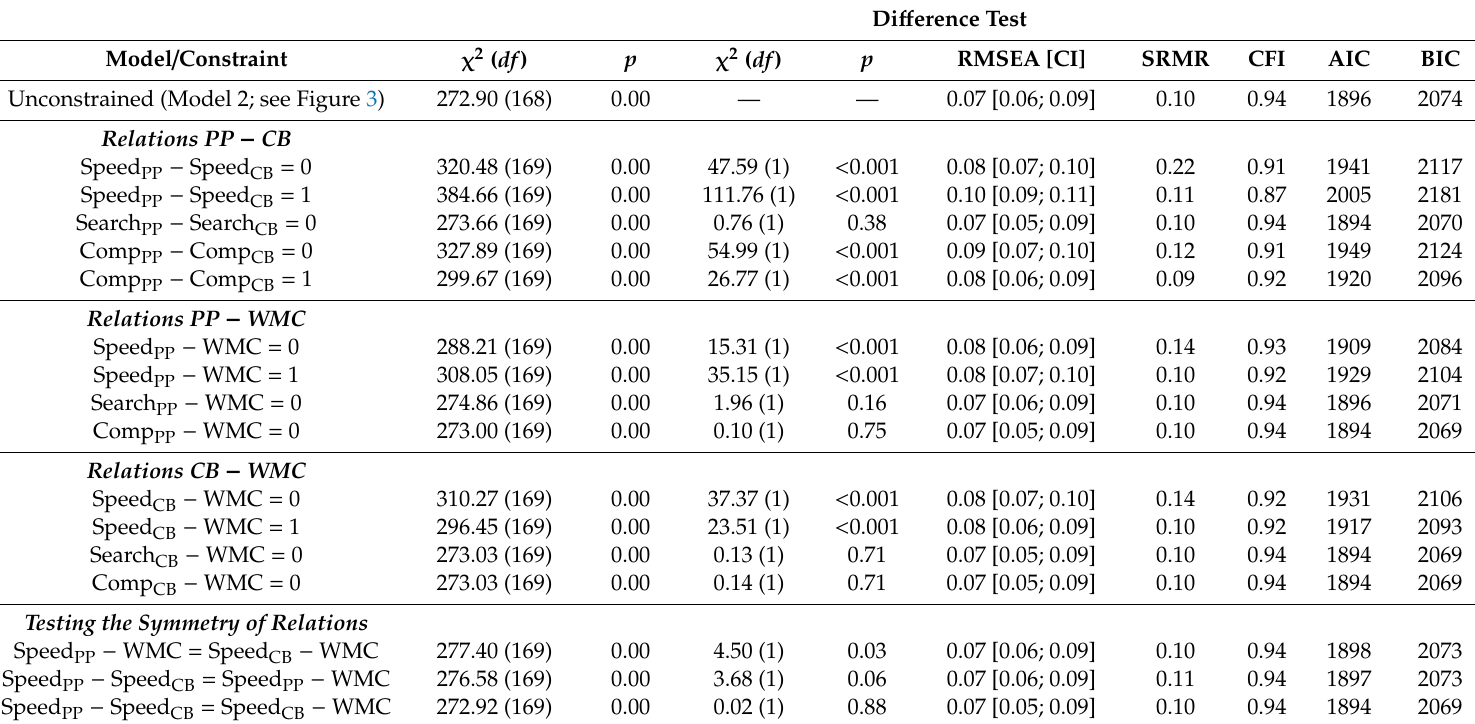
Table A2. Fit of Bifactor